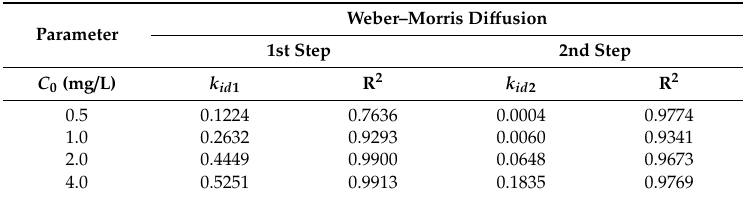
Table 2. Rate constants for the kinetic model of the adsorption of As(V) on NZVI / AC at di ff erent initial As(V) concentrations.